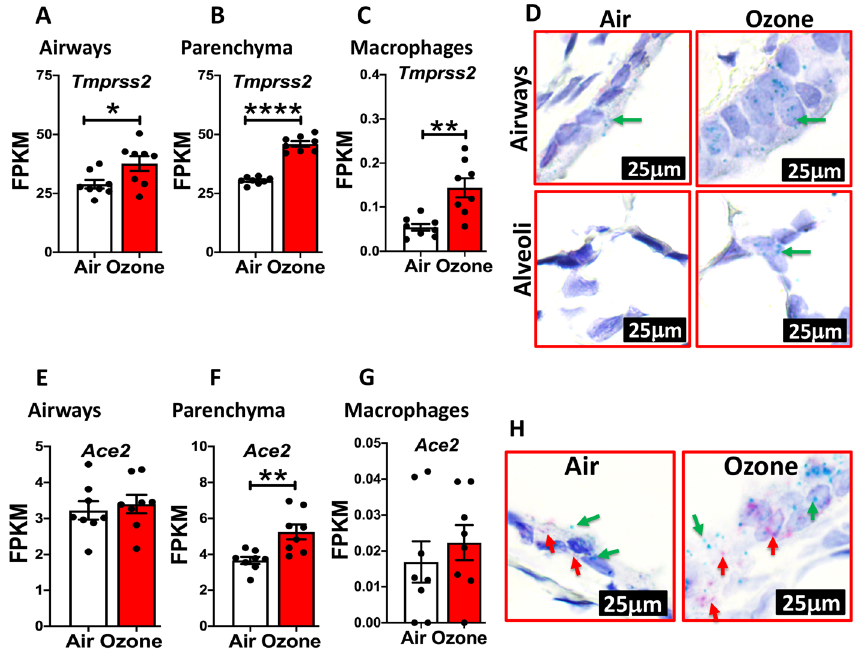
Figure 2. Tmprss2 mRNA expression is upregulated in the lungs of ozone -exposed mice. FPKM values obtained from RNAseq data set obtained from airways ( A ), parenchyma ( B ), and alveolar macrophages ( C ) were used to quantify relative expression levels of Tmprss2 mRNA in air- versus ozone-exposed mice (n = 8). The data are expressed as mean (± SEM). Student’s t-Test; * P < 0.05, ** P < 0.01, **** P < 0.0001. ( D ) RNAscope-based in situ hybridization for Tmprss2 transcripts (green dots representing punctate staining for Tmprss2 mRNA in airway epithelial cells (Top) and alveolar epithelial cells (bottom) in air- (left) and ozone-exposed (right) mice. All images were captured at the same magnification. FPKM values obtained from RNAseq data set obtained from airways ( E ), parenchyma ( F ), and alveolar macrophages ( G ) were used to quantify relative expression levels of Ace2 mRNA in air- versus ozone-exposed mice (n = 8). The data are expressed as means (± SEM). Student’s t-Test ** P < 0.01. ( H ) Duplex RNAscope-based in situ hybridization for Tmprss2 (green puncta, green arrow) and Ace2 (red puncta, red arrow) in the airways of air- (left) and ozone-exposed (right) mice. All images were captured at the same